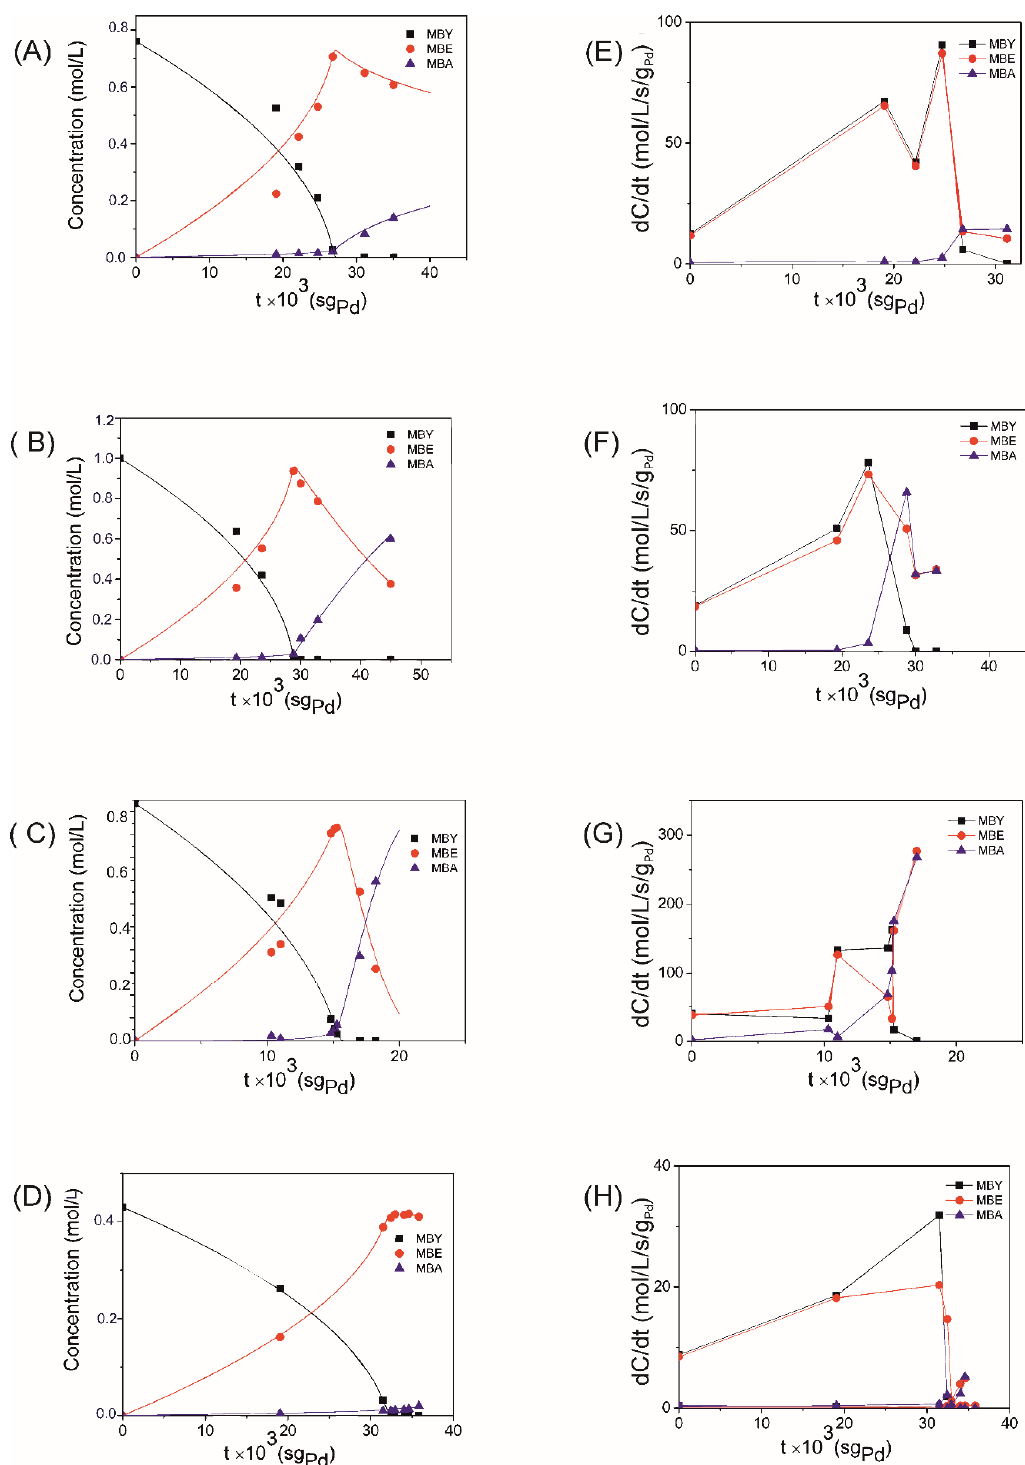
Figure 4. Dependences of the concentrations of MBY, MBE and MBA on the contact time after 28 h of continuous flow on PdZn/TiO 2 ( A ), PdZn/Ti 0.8 Zr 0.2 O 2 ( B ), PdZn/Ti 0.95 Ce 0.05 O 2 ( C ), PdZn/Ti 0.8 Zn 0.2 O 1.8 ( D ), points - experiment, lines - calculation by the Langmuir–Hinshelwood model; also the dependence of the reaction rate on the contact time after 28 h of continuous flow on the PdZn/TiO 2 ( E ), PdZn/Ti 0.8 Zr 0.2 O 2 ( F ), PdZn/Ti 0.95 Ce 0.05 O 2 ( G ), PdZn/Ti 0.8 Zn 0.2 O 1.8 ( H ). Reaction conditions: gas flow rate 6.0 mL / min, = 1 atm, T = 313 K.